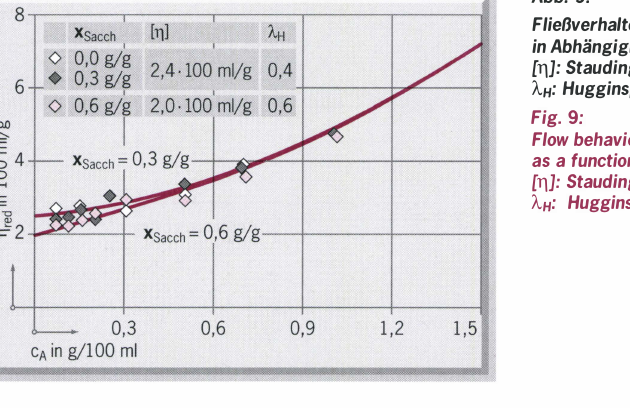
Fig. 9: Flow behavior of agar suspensions in sugar solution as a function of sugar concentration. [11]: Staudinger Index in 100 mljg AH: Huggins parameter